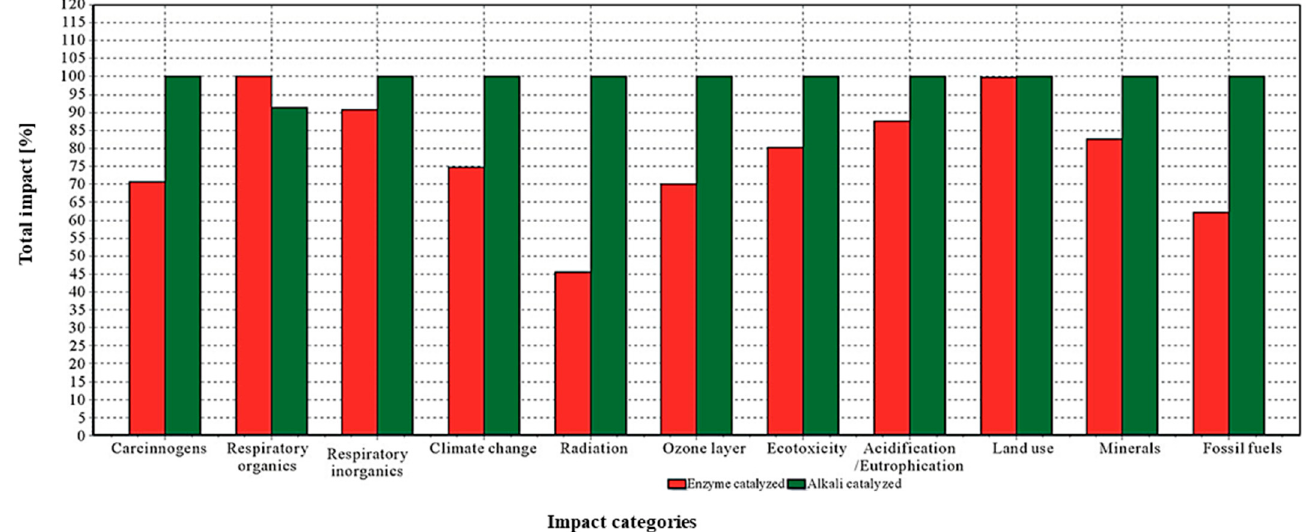
Figure 3. Results of the comparative lifecycle analysis of enzyme-catalyzed biodiesel production and the alkali-catalyzed biodiesel production technology [74].